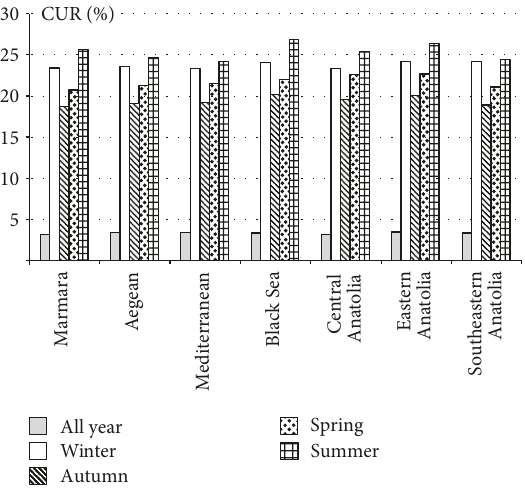
Figure 5: Changes in electrical capacity utilization rates.